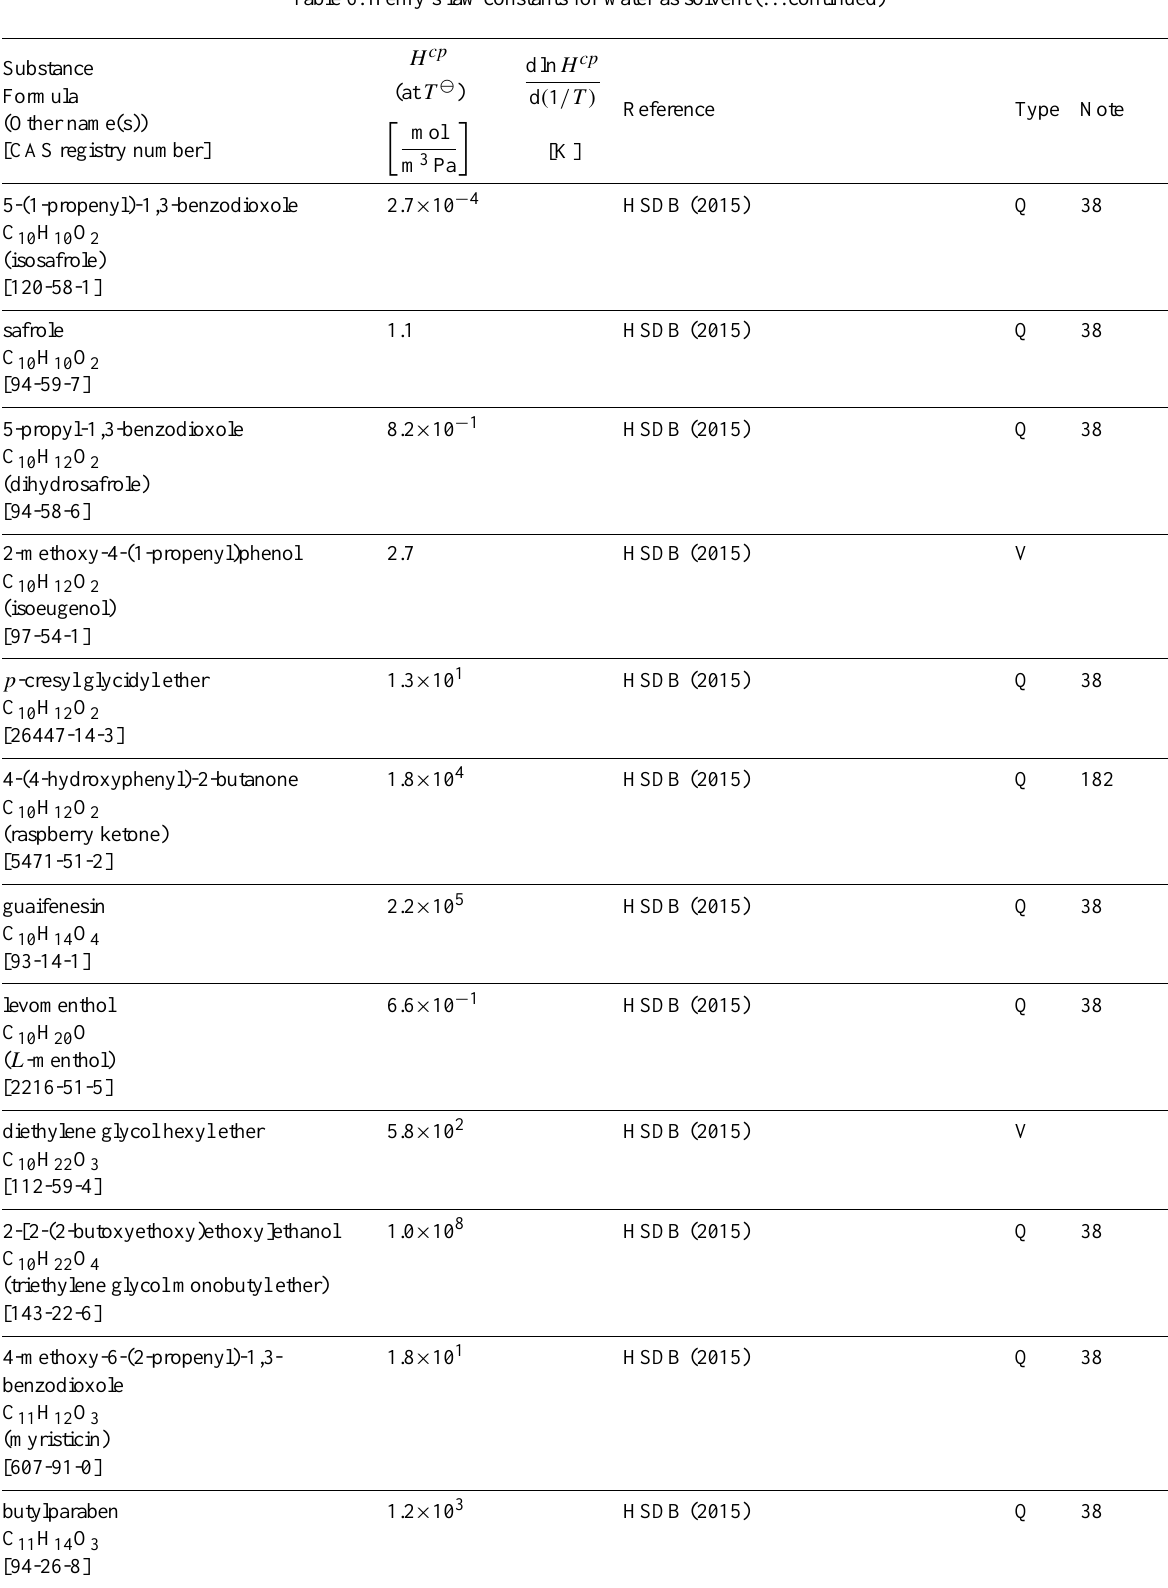
Table 6: Henry’s law constants for water as solvent